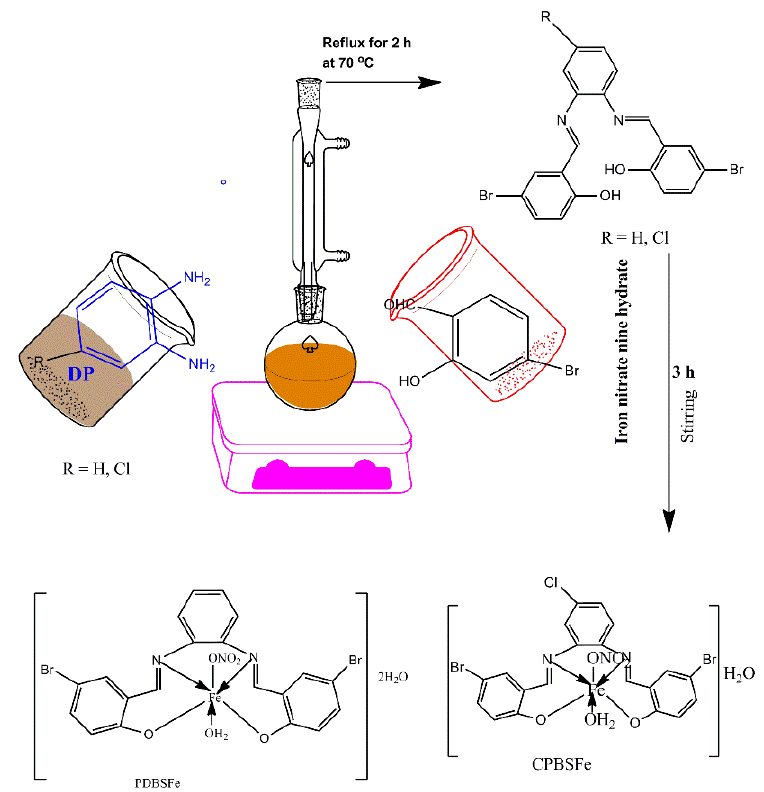
Figure 2. The curves of synthesized metal chelates in EtOH using Job’s technique at [Fe 3+ ] = [L] = 10 − 3 M at 298 K.